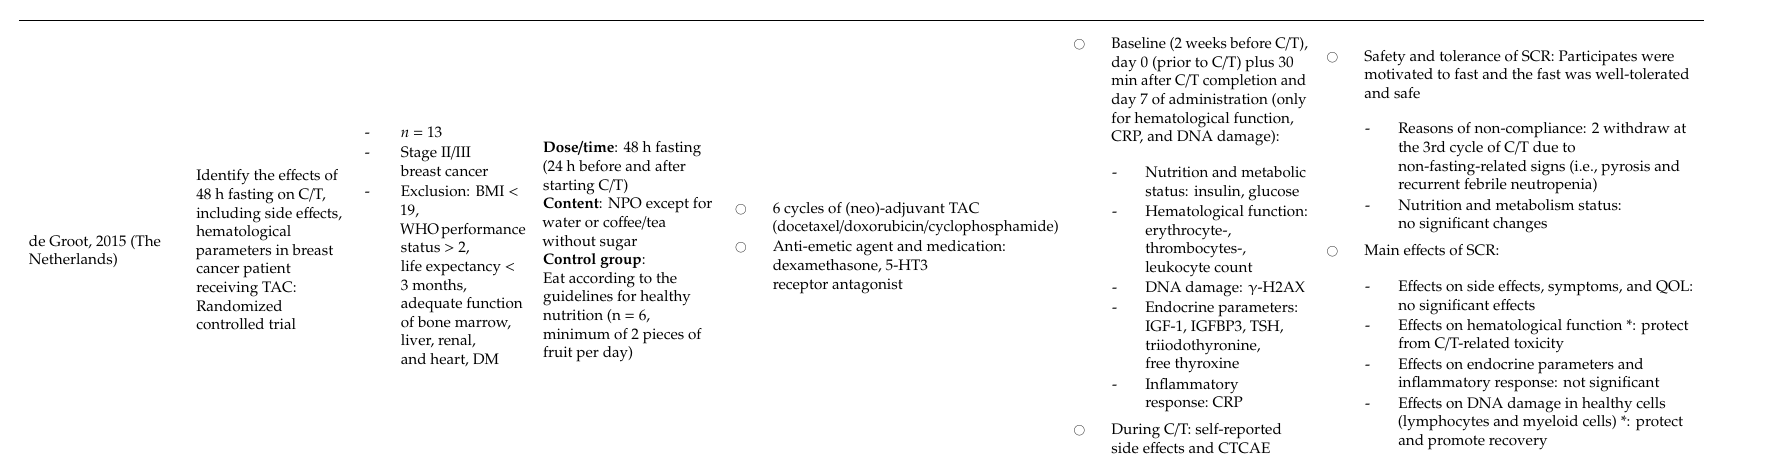
E ff ects on side e ff ects, symptoms, and QOL: no significant e ff ects - E ff ects on hematological function *: protect from C / T-related toxicity - E ff ects on endocrine parameters and inflammatory response: not significant - E ff ects on DNA damage in healthy cells (lymphocytes and myeloid cells) *: